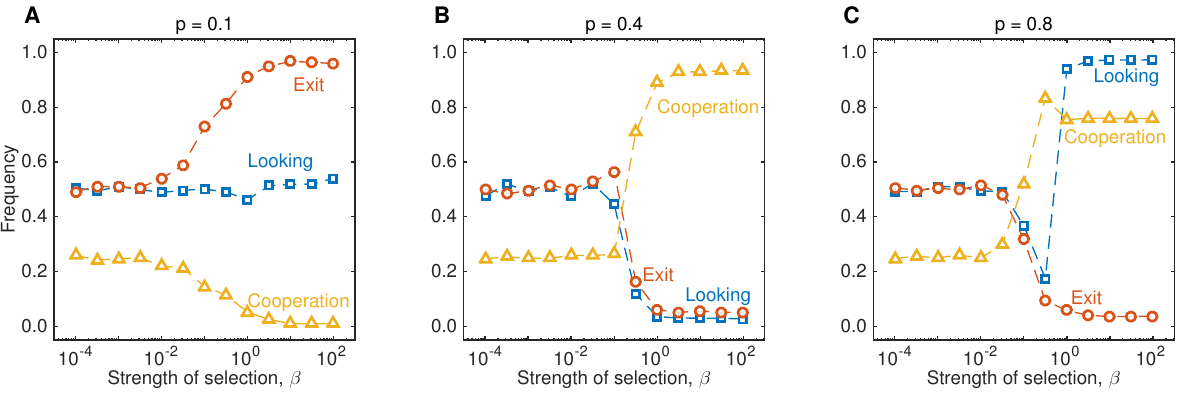
Figure 4. Results of the evolutionary simulations for different strengths of selection.